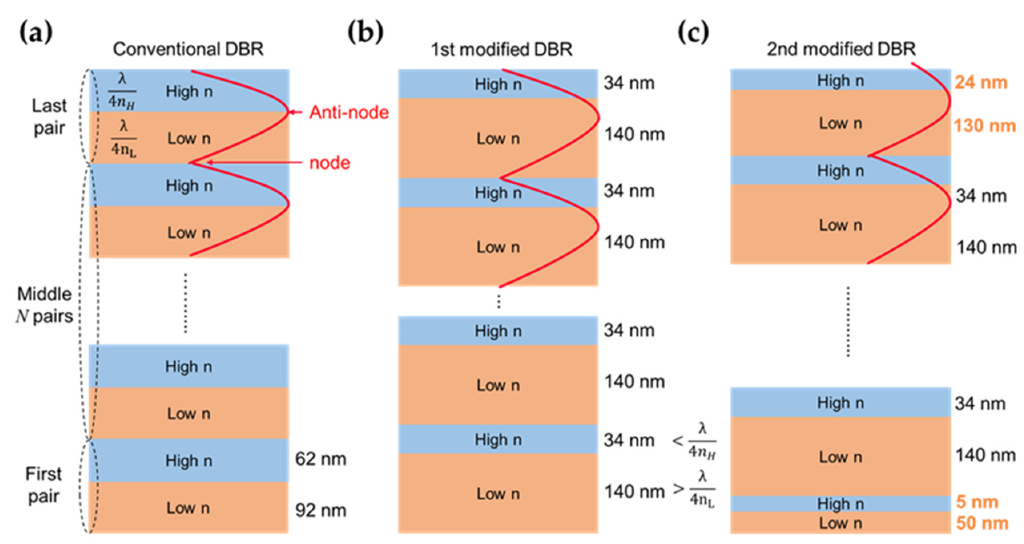
Figure 3. Schematic illustrations for ( a ) conventional DBR, ( b ) 1st modified DBR, and ( c ) 2nd modified DBR structures.